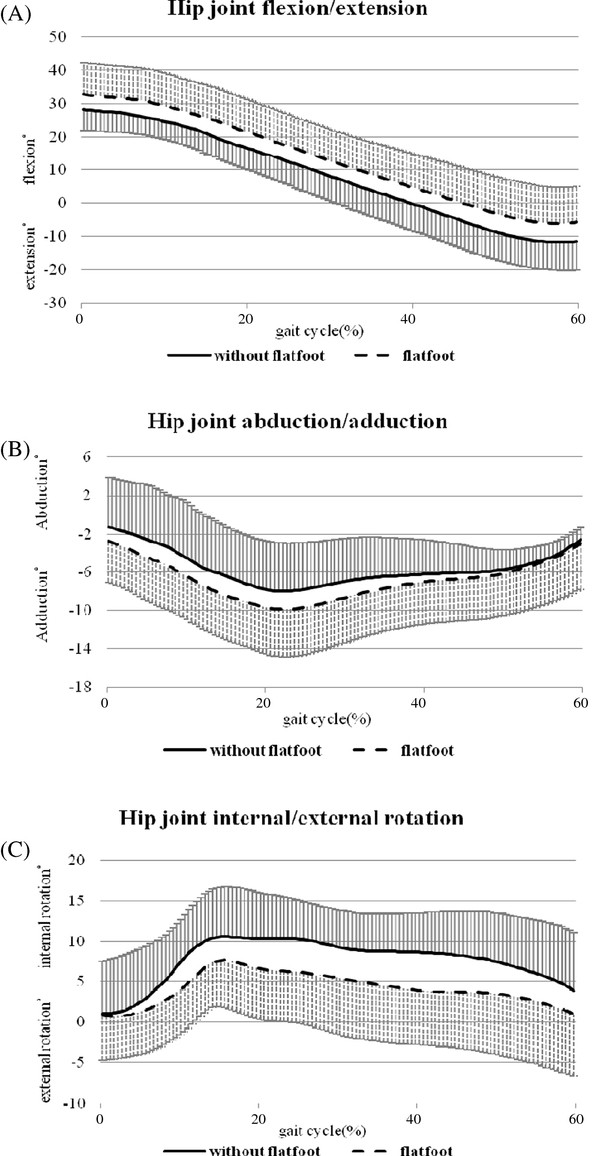
Movement pattern of the hip joint. (A) Flexion/extension, (B) abduction/adduction, and (C) internal/external rotation in children with (n = 20) and without (n = 10) flexible flatfoot during the stance phase (0-60% of the gait cycle) of comfortable walking. The standard deviations are shown in one direction.